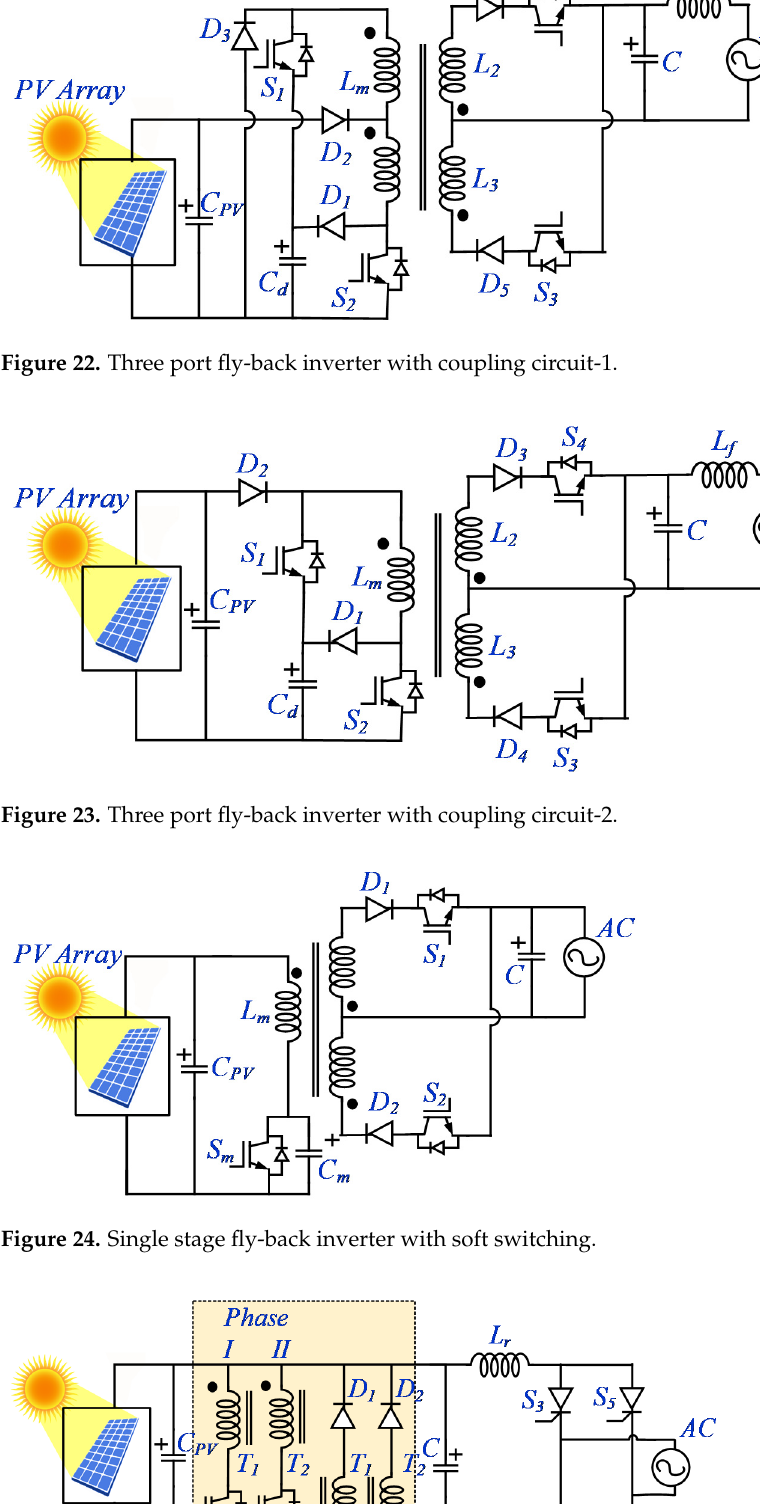
Figure 25. Single phase two-phase interleaved fly-back converter .